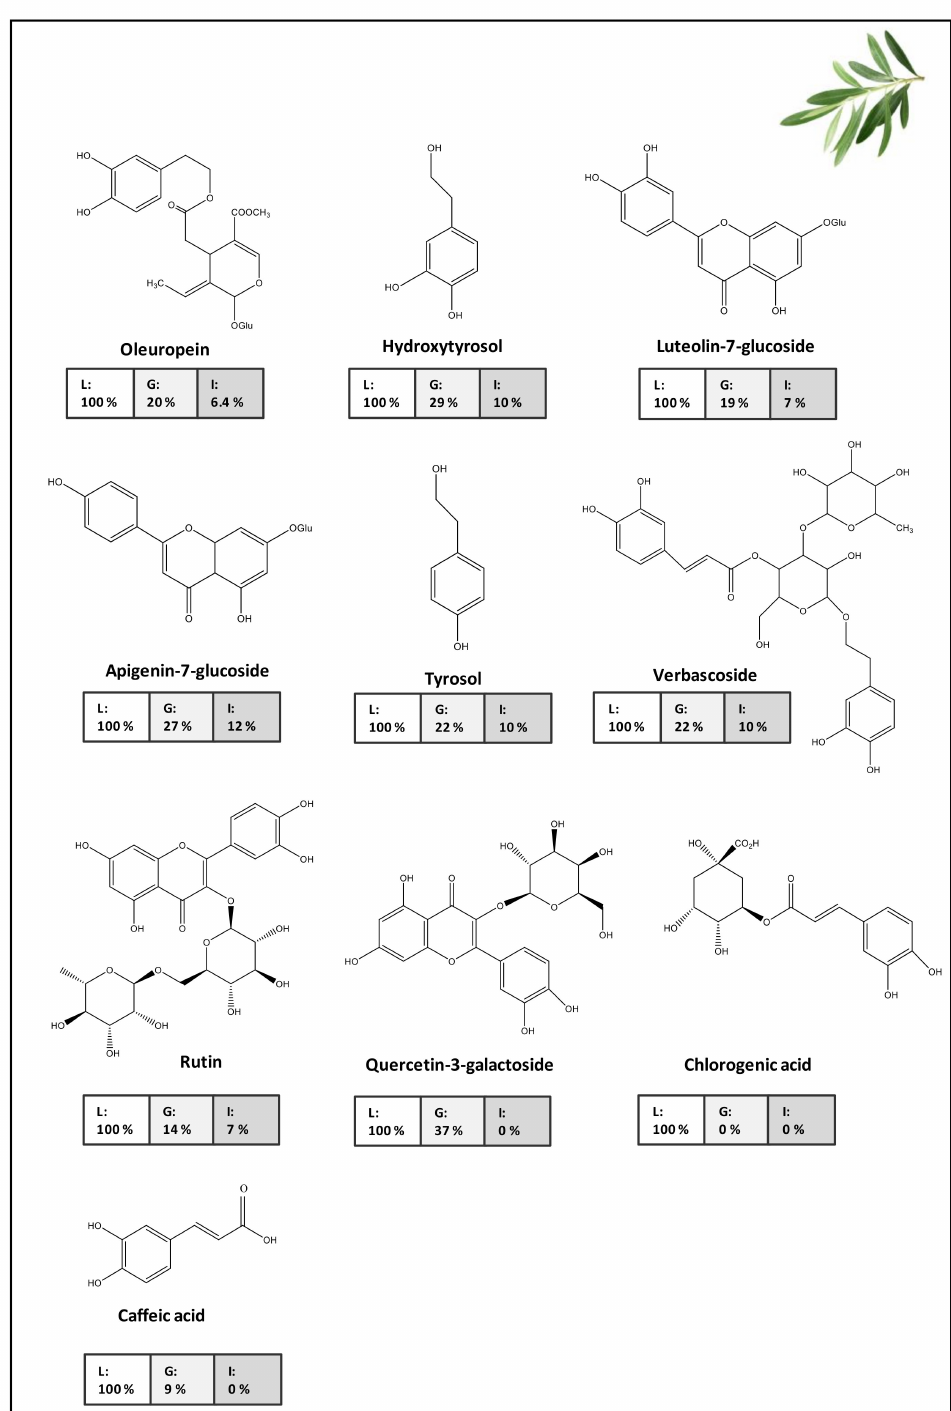
Figure 5. Phenolic compounds determined in leaves. Variation (%) of the phenolic compounds after gastric (G) and intestinal (I) digestion with respect to the initial content in leaves (L). Data taken from Mart í n-Vertedor et al.